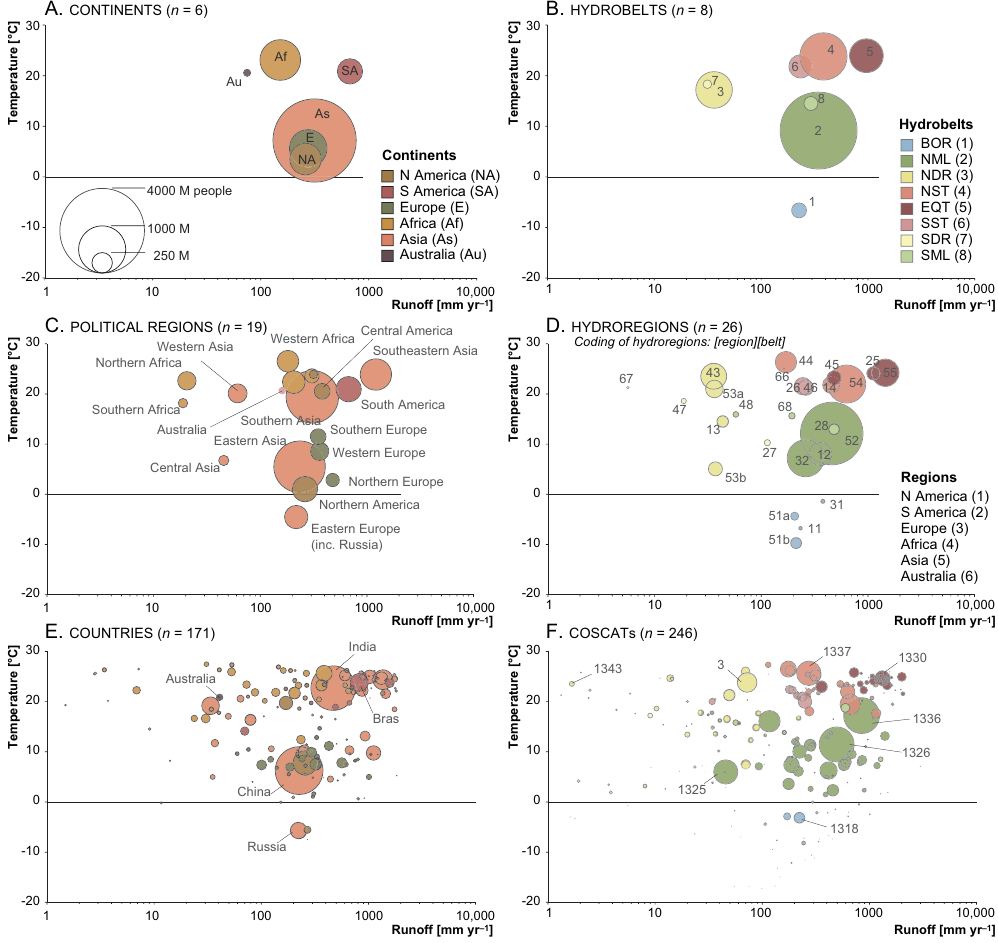
Fig. 7. Bubble chart of populations represented in a run-off vs. temperature domain. (a) Reporting using continents; (b) hydrobelts; (c) po- litical regions; (d) hydroregions; (c) countries; (f) Coastal catchments (COSCATs); COSCAT numbers from Meybeck et al. (2006)) (30 0 cell averages of annual figures for temperatures and